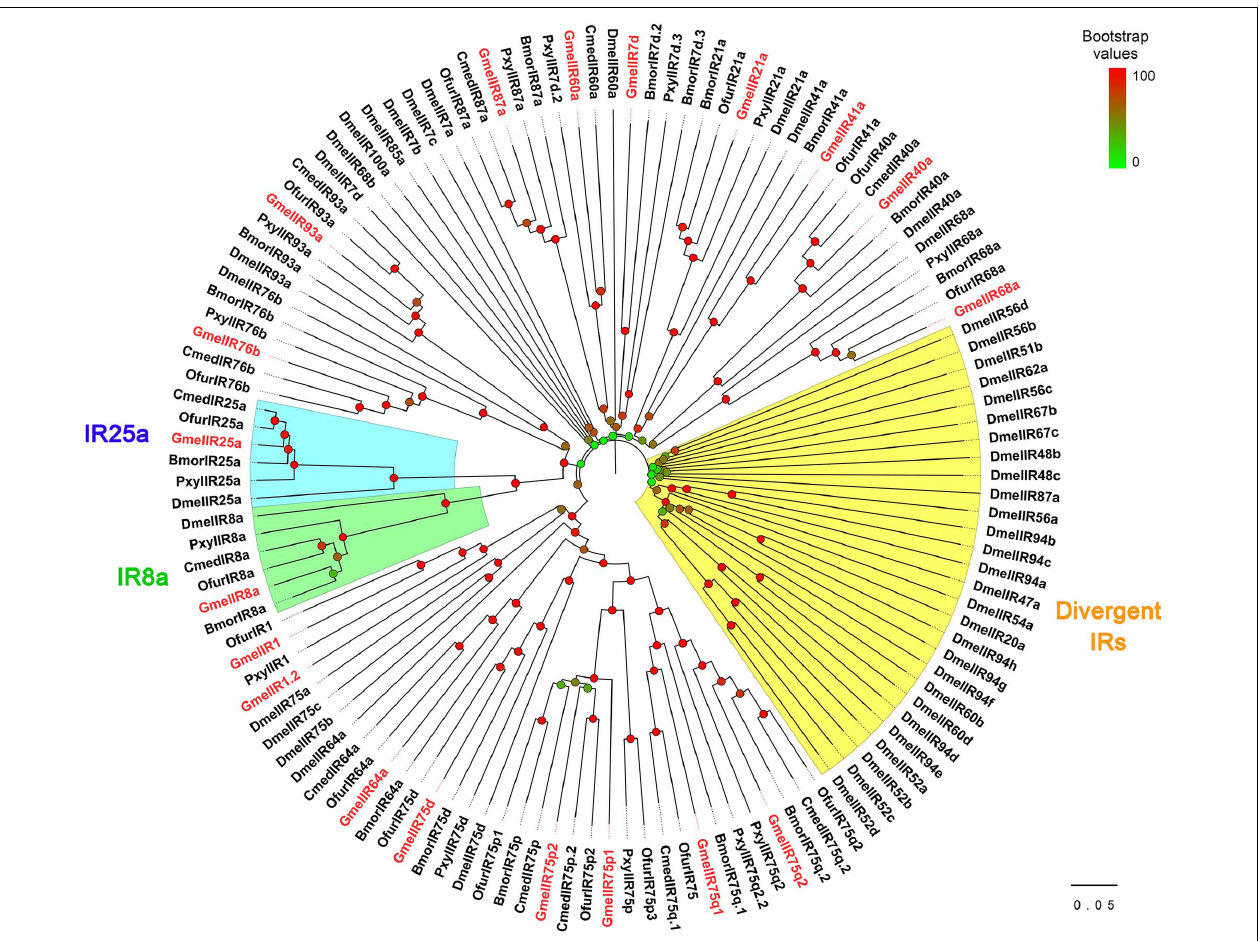
FIGURE 7 | Phylogenetic relationships of insect IRs. Dmel: Drosophila melanogaster ; Bmor: Bombyx mori ; Ofur: Ostrinia furnacalis ; Pxyl: Plutella xylostella ; Cmed: Cnaphalocrocis medinalis . Bootstrap values are indicated by colors from green (0) to red (100). The G. mellonella IRs are highlighted in red. GenBank accession numbers of IRs used are listed in Supplementary Table 1